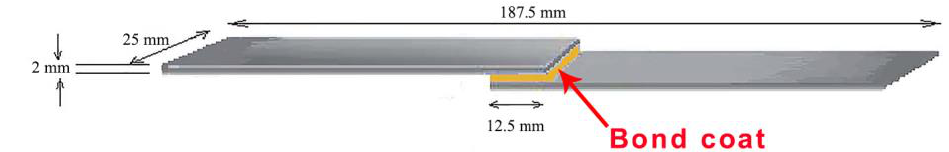
Figure 3. Schematic illustration of the sample for the single-lap shear